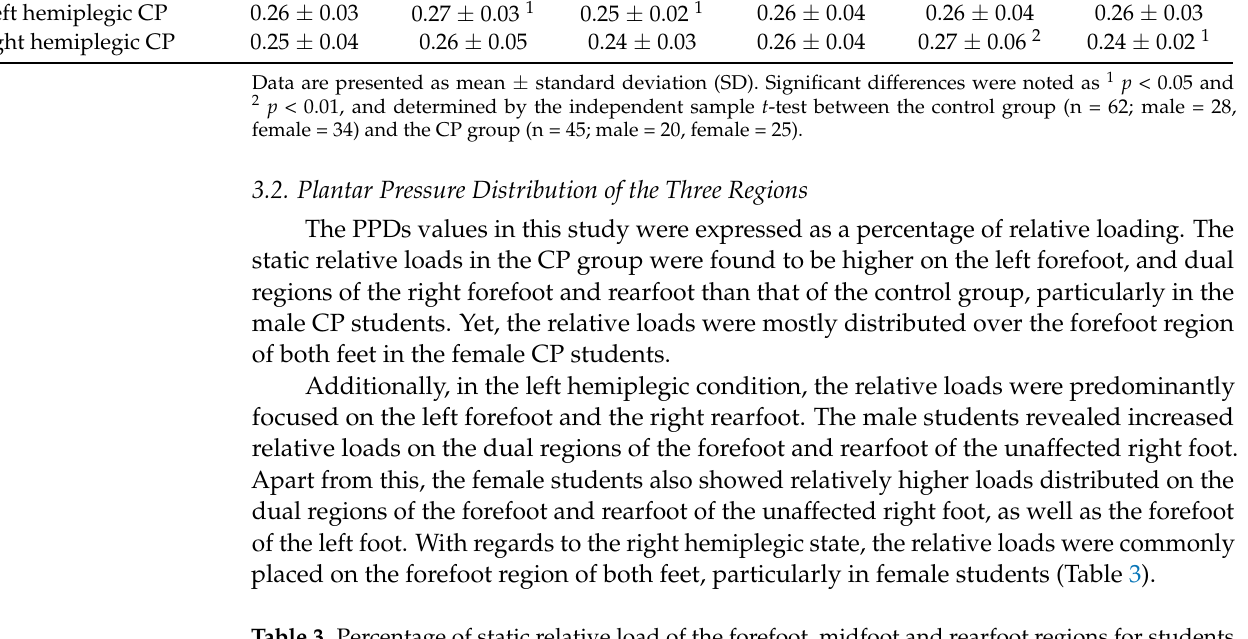
Table 3. Percentage of static relative load of the forefoot, midfoot and rearfoot regions for students diagnosed with hemiplegic cerebral palsy and healthy college